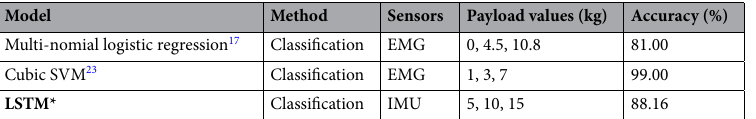
Table 4. Performance comparison of our method (*) and state-of-the-art EMG-based